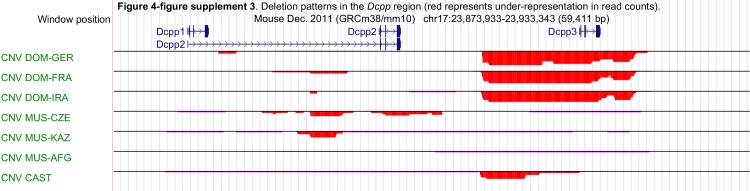
Deletion patterns in the Dcpp gene region of the different Mus musculus populations.